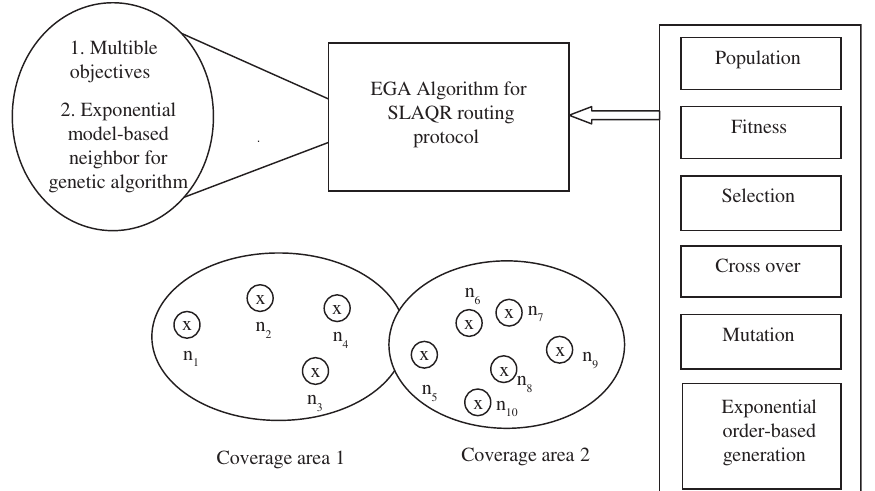
Figure 2: Block Diagram of the Proposed SLAQR